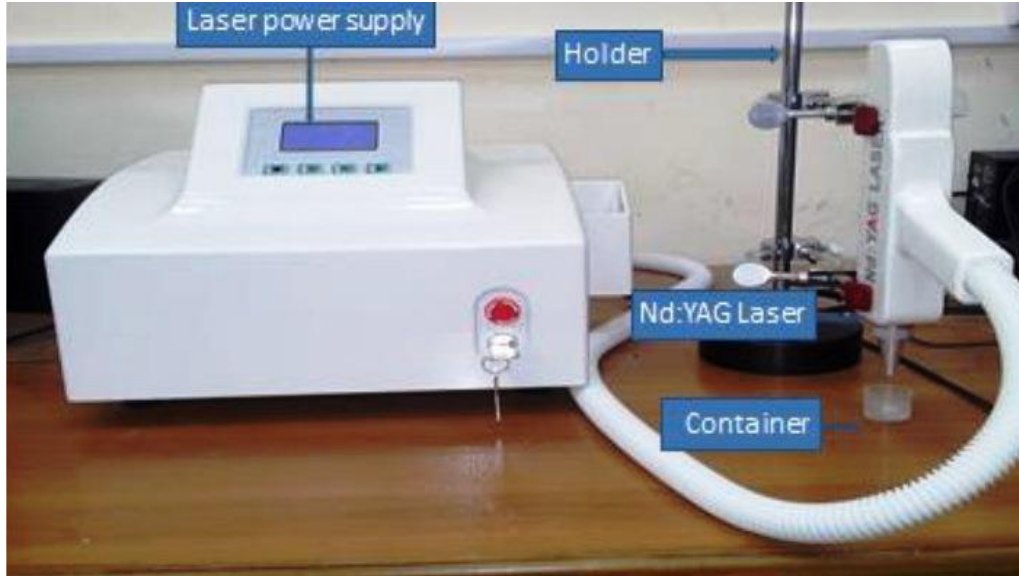
Fig. 2: Schematic of system used to prepare the colloidal nanoparticles.